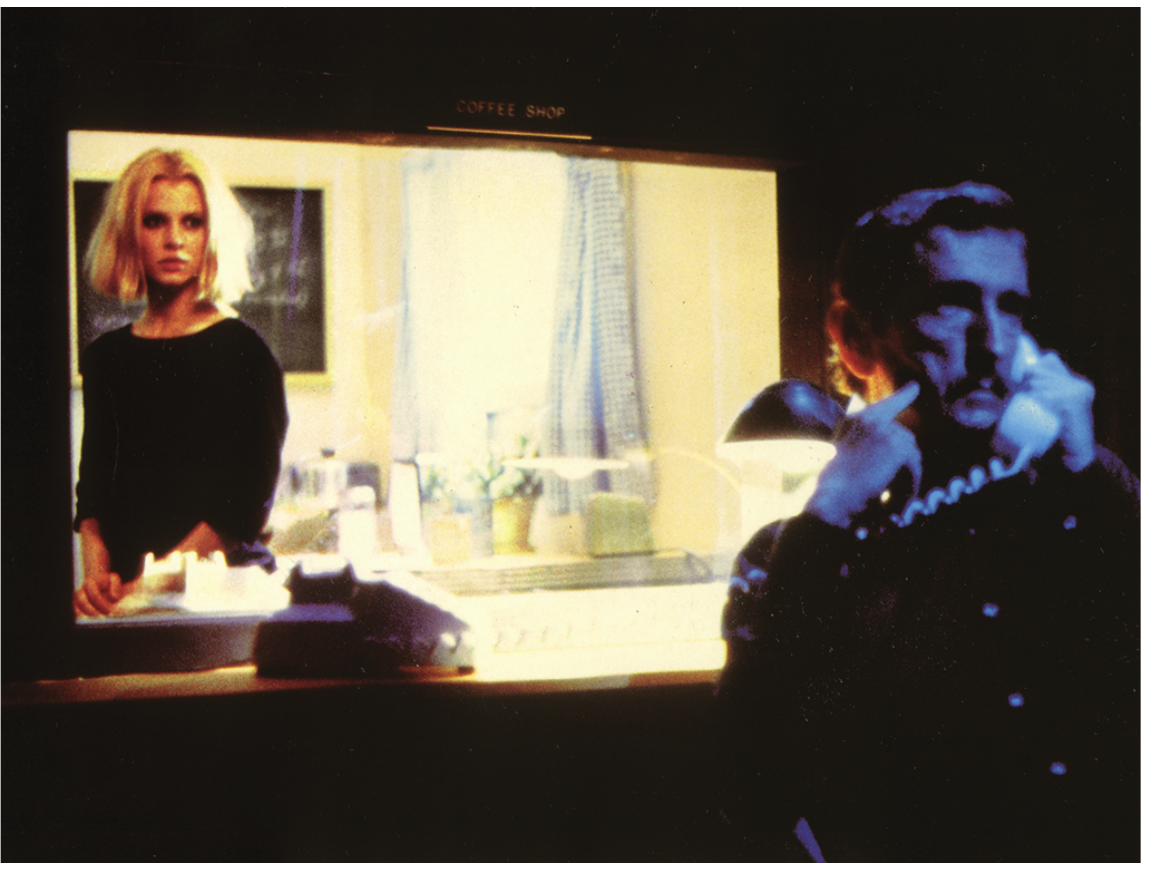
Figure 5: The inconic joourney’s end Paris,